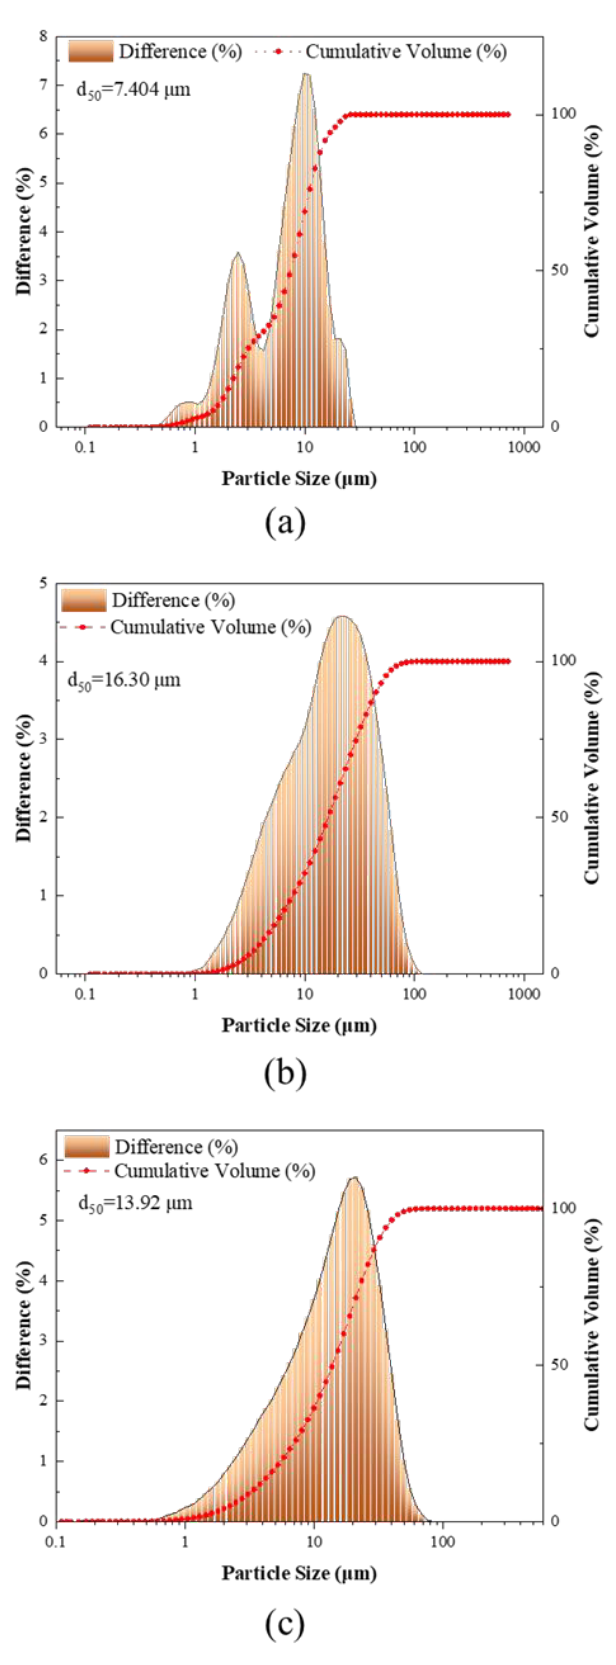
Figure 3. Particle size distribution: ( a ) OPC; ( b ) CAG; ( c ) CMT.